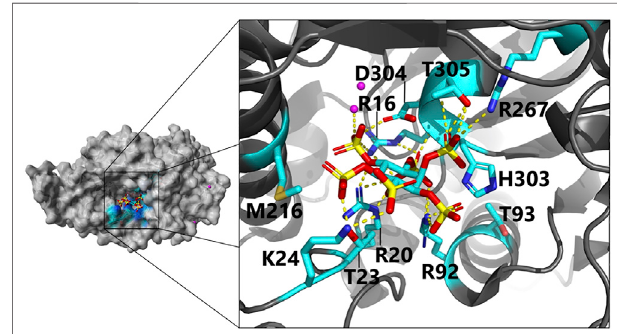
FIGURE 4 | Close-up view of the active site in E. coli phytase in a complex with phytate (InsP 6 ) as substrate (PDB code 1DKQ): Negatively charged InsP 6 is predominantly bound by positively charged and polar residues via hydrogen bonds to the active site residues. Magenta dots indicate Hg 2+ cations used for crystallization of the phytate-bound complex. For clarity, only direct interactions of residues with InsP 6 and identi fi ed bene fi cialphytaseengineeringpositionsareshown(colorscheme:C,cyan;O, red; N, blue; P, yellow; yellow dotted lines, hydrogen bonds). Dependent on the protonation state, H303 canalso interact via hydrogen bonding with InsP 6 [more details on the proposed binding mode including indirect hydrogen bonding interactions are depicted here (Lim et al.,